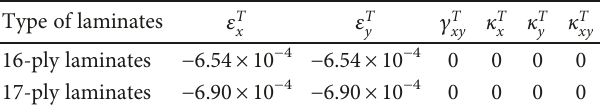
Table 4: Simulation results of hybrid A